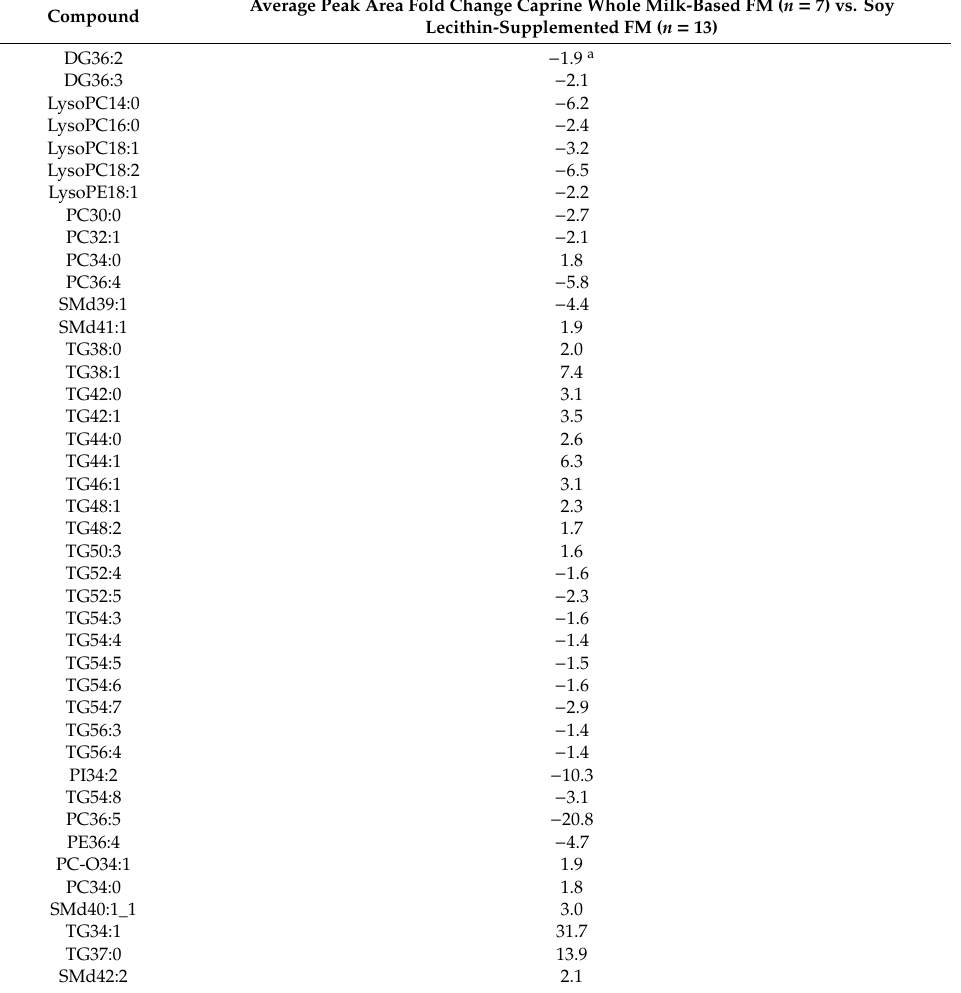
Table 3. The short-list of statistically significantly di ff erent lipids between the samples of caprine whole milk-based FM and FM supplemented with soy lecithin, accordingly to the Mann–Whitney test unpaired (multiple testing correction: Benjamini–Hochberg, p < 0.01). The complete list is presented in Table S10 in the Supplementary